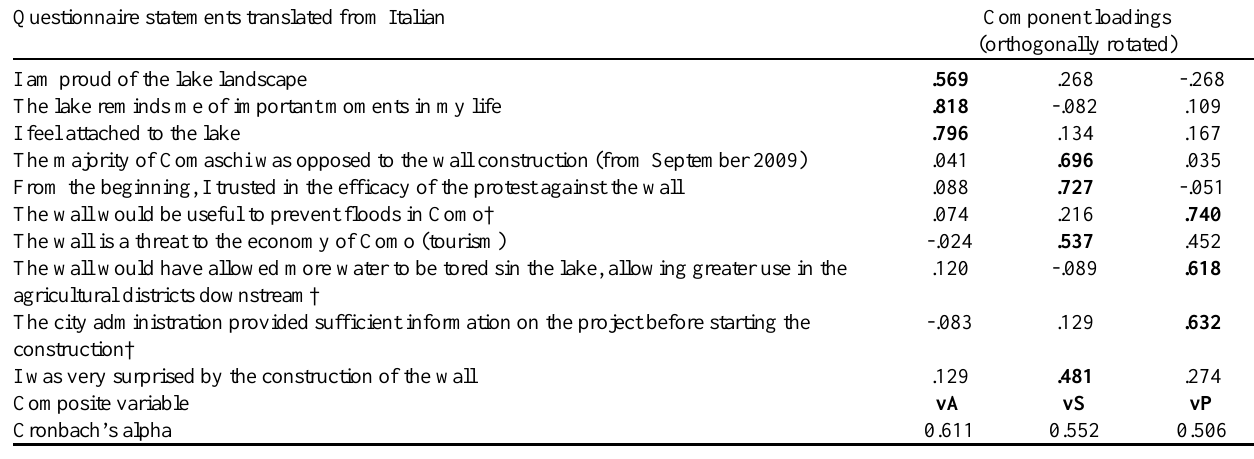
Table 1. PCA loadings for questionnaire items after rotation (Varimax with Kaiser normalization); questionnaire statements were translated from